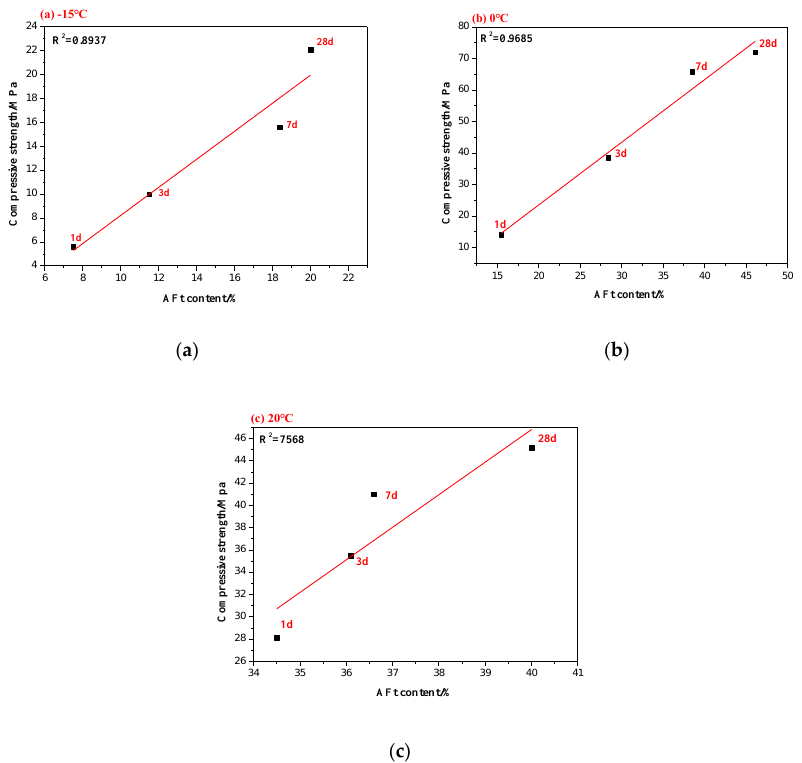
Figure 7. Relationship between the AFt content and compressive strength: ( a ) −15 °C , ( b ) 0 °C ; and ( c ) 20 °C .